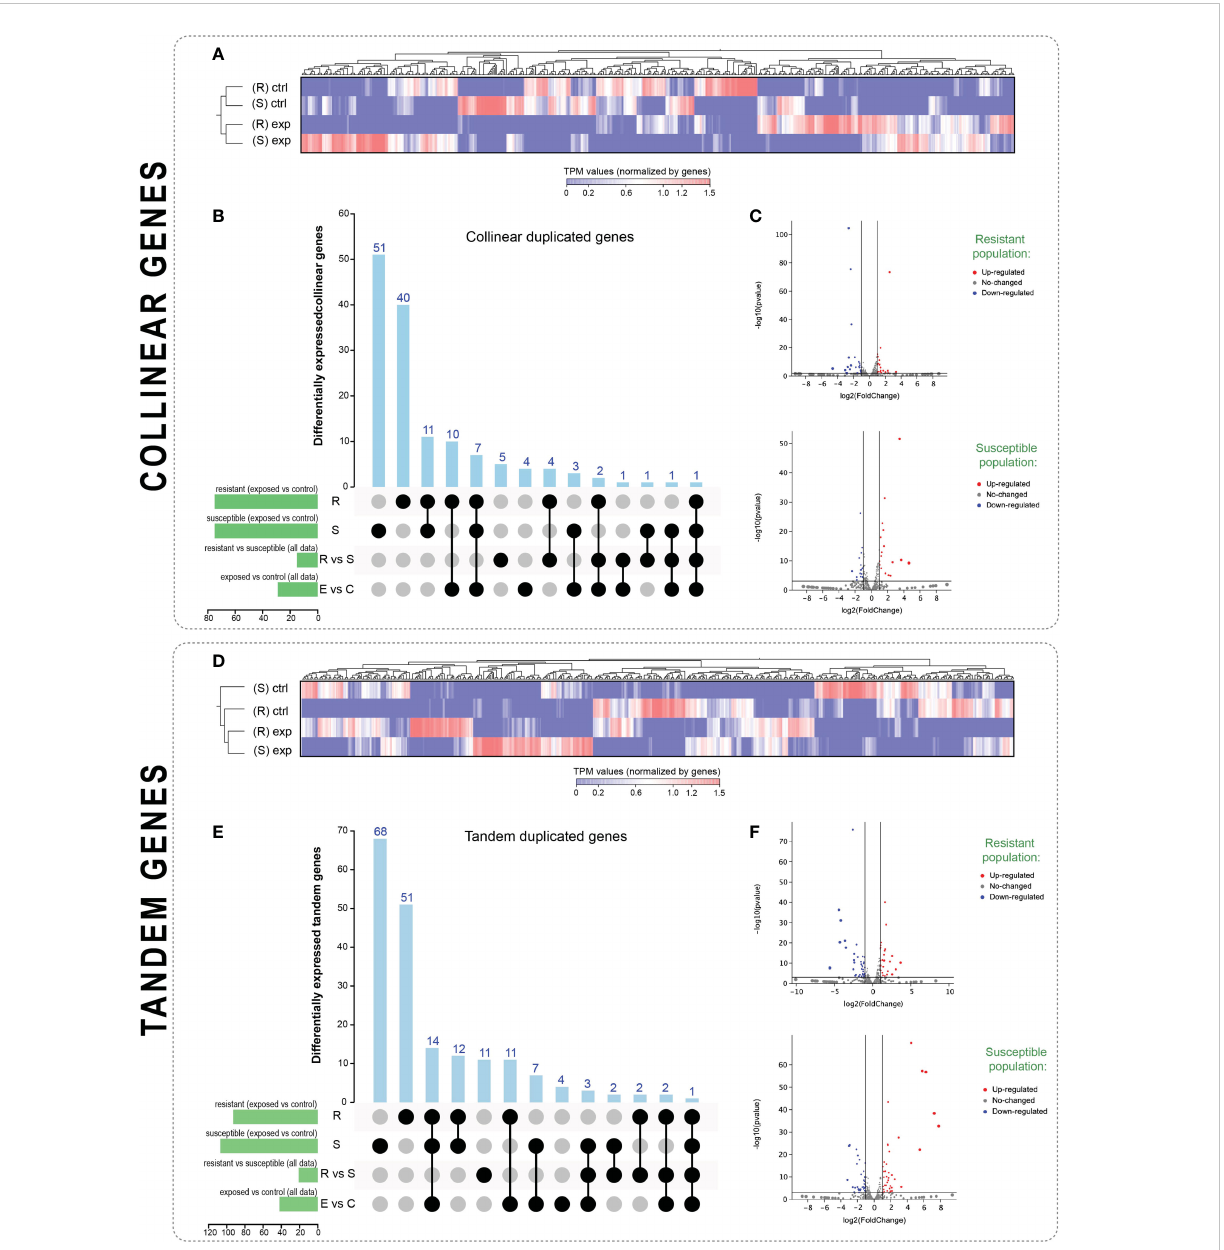
FIGURE 3 Expression analyses of collinear and tandem duplicated genes in the resistant and susceptible strains of sea lice. (A, D) : Hierarchical clustering of TPM values of collinear genes (A) and tandem genes (D) based on Manhattan ’ s distances with an average linkage. Red color corresponds to high expression values and blue to low expression values. (R): resistant strain; (S): susceptible strain; ctrl: untreated groups; exp: parasites treated with azamethiphos. (B, E) : Upset plot counting the number of differentially expressed genes for collinear (B) and tandem (E) duplicated genes for all the statistical comparisons conducted in this study. Differentially expressed genes cutoff was |Fold change| > 4.0; P-value < 0.01. R: statistical comparison on exposed vs. control lice in the resistant strain; S: the same comparison for susceptible lice; R vs. S: statistical comparison between TPM values from the resistant strain vs. the susceptible strain; E vs. C: statistical comparison between TPM values from the exposed parasites versus control samples independently of the strain. (C, F) : Volcano plot of differentially expressed genes for each population for collinear (C) and tandem (F)